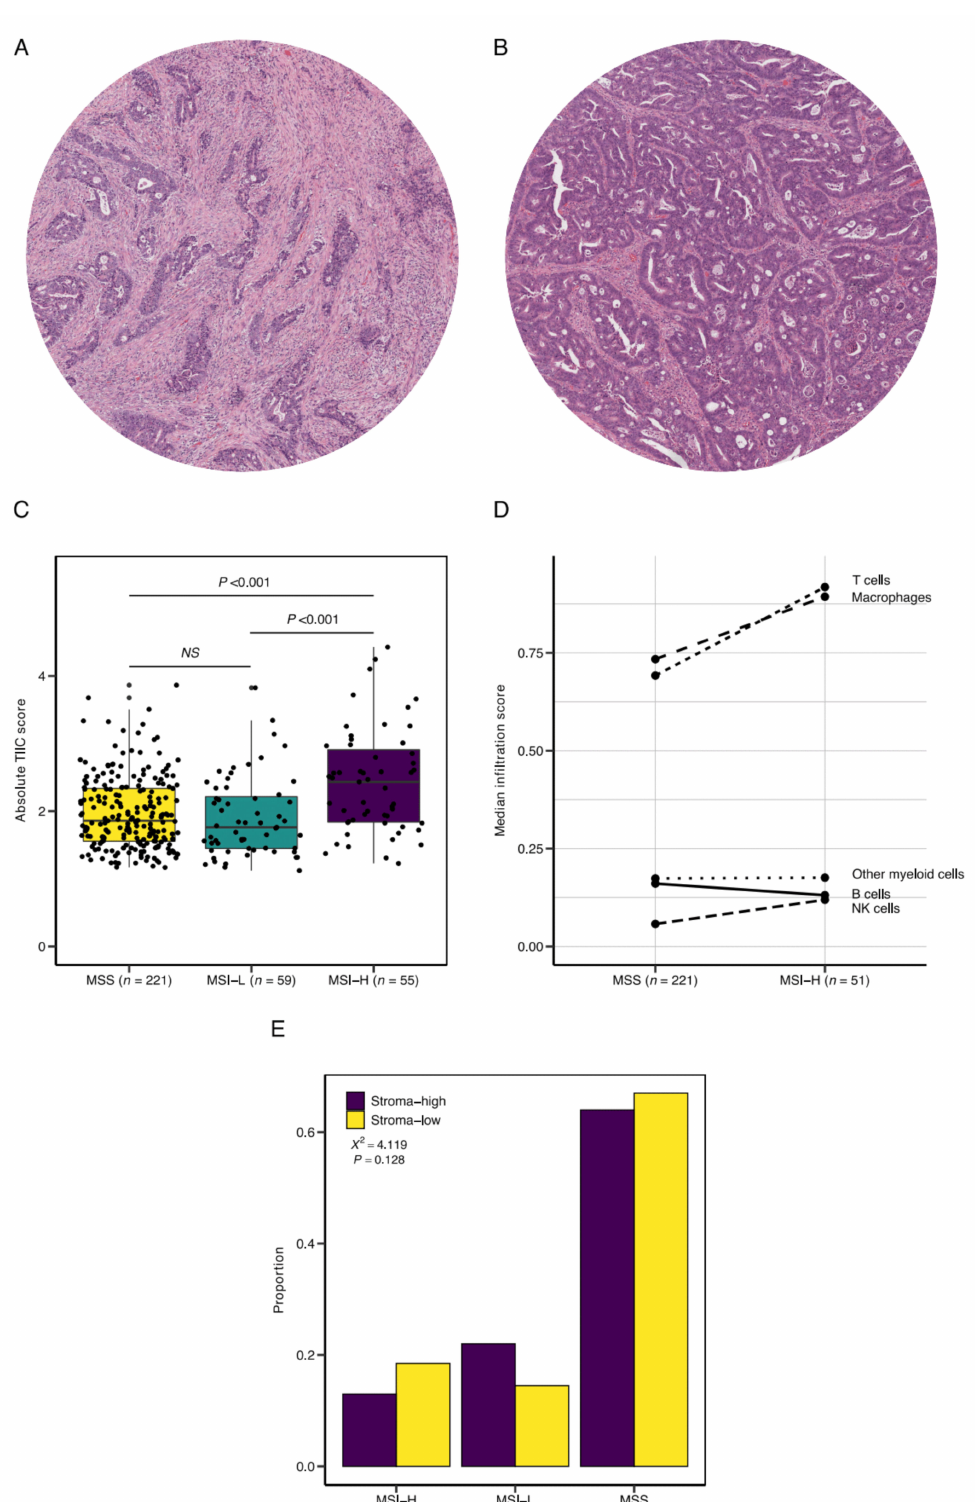
Figure 2. Tumor-infiltrating immune cells (TIICs) and microsatellite status. Representative illustrations of ( A ) stroma-high and ( B ) stroma-low tumors, as scored by the tumor–stroma ratio (TSR). ( C ) Total TIIC infiltration in microsatellite stable (MSS), low microsatellite instability (MSI-L), and high microsatellite instability (MSI-H) tumors. ( D ) Specification of 5 large TIIC subsets in MSS versus MSI-H tumors. ( E ) Proportion of stroma-high and stroma-low tumors in the microsatellite status subgroups. NS, non-significant; X2, chi-squared